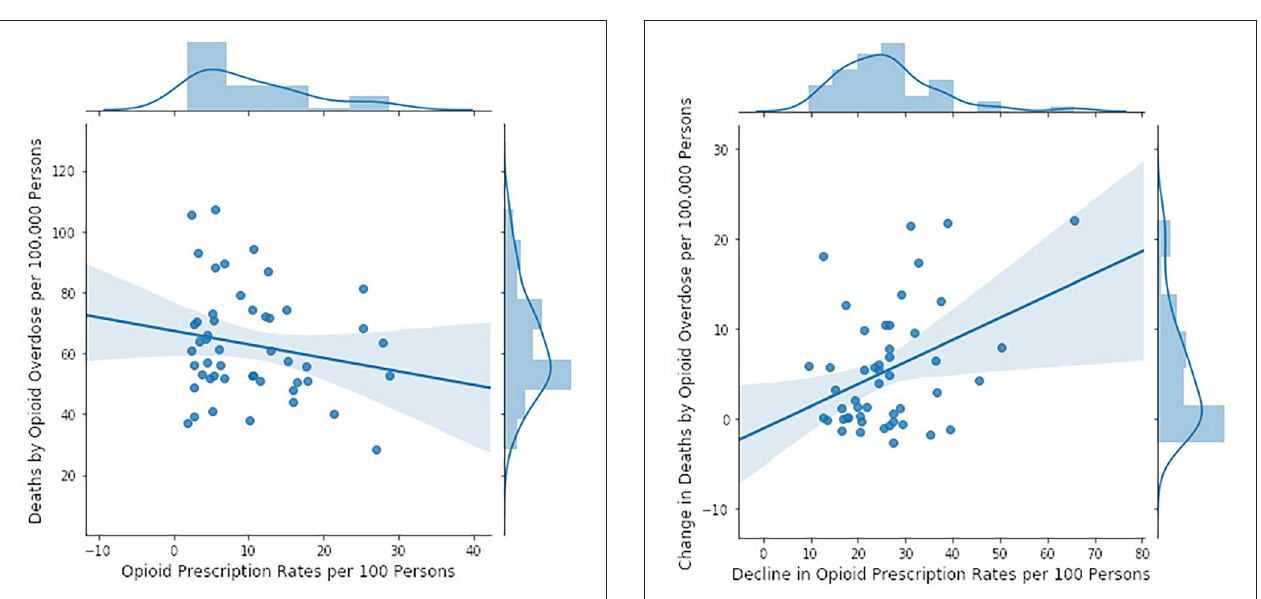
FIGURE 5 | Changes in mortality rates by state (calculated as in Figure 4 ) between the year of maximal prescription rate and 2017 (111) in relation to the decline in opioid prescription rates from their maximum in the 2006–2016 epoch to 2017 ( 110) (CDC data). The model accounted for 13% of the variance. The slope of the regression line is significantly different from zero ( F = 8.298, p =